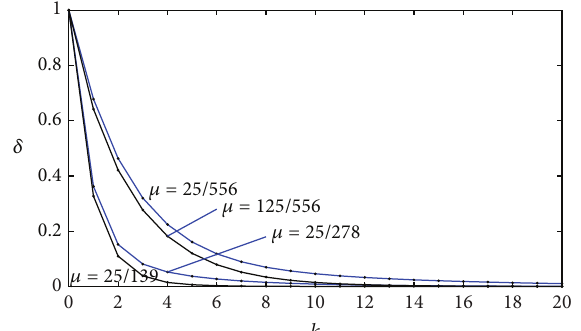
Figure 1: The relative error 𝛿 versus 𝑘 (dots: 𝜇 0 = max {∑ 2 𝑖=1 ‖ A 𝑖 ‖ 2 ‖ B 𝑖 ‖ 2 ,∑ 2 𝑗=1 ‖ C 𝑗 ‖ 2 ‖ D 𝑗 ‖ 2 } = 11.12 ).